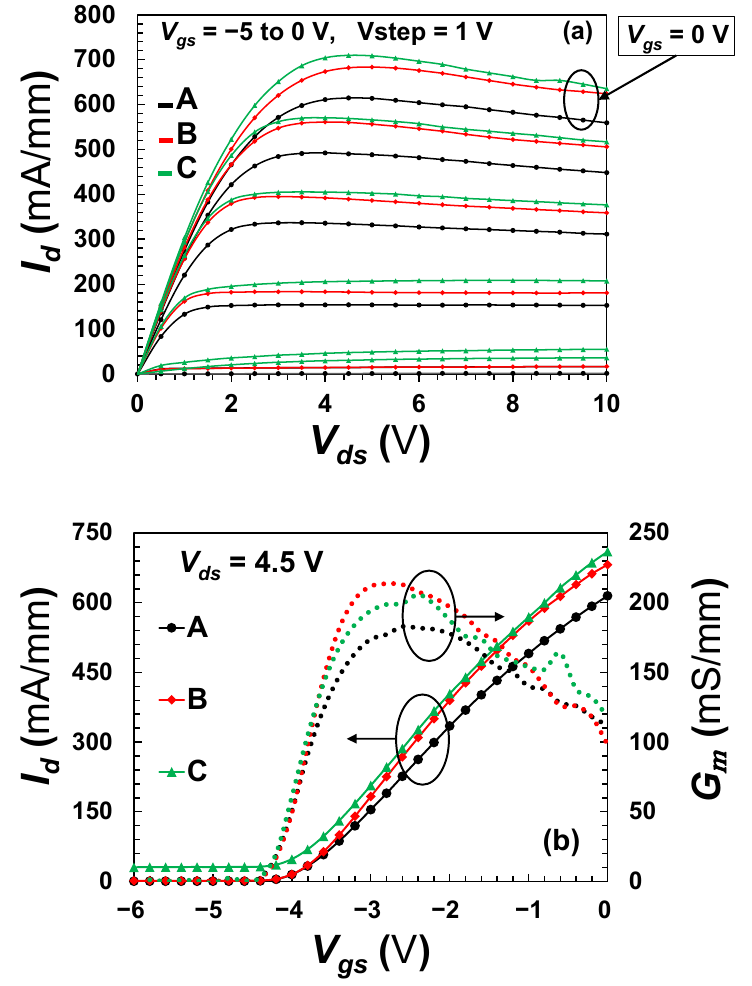
Figure 6. ( a ) I-V family curves of 2-finger 125 µm wide device, ( b ) the corresponding transfer characteristics of the three devices.